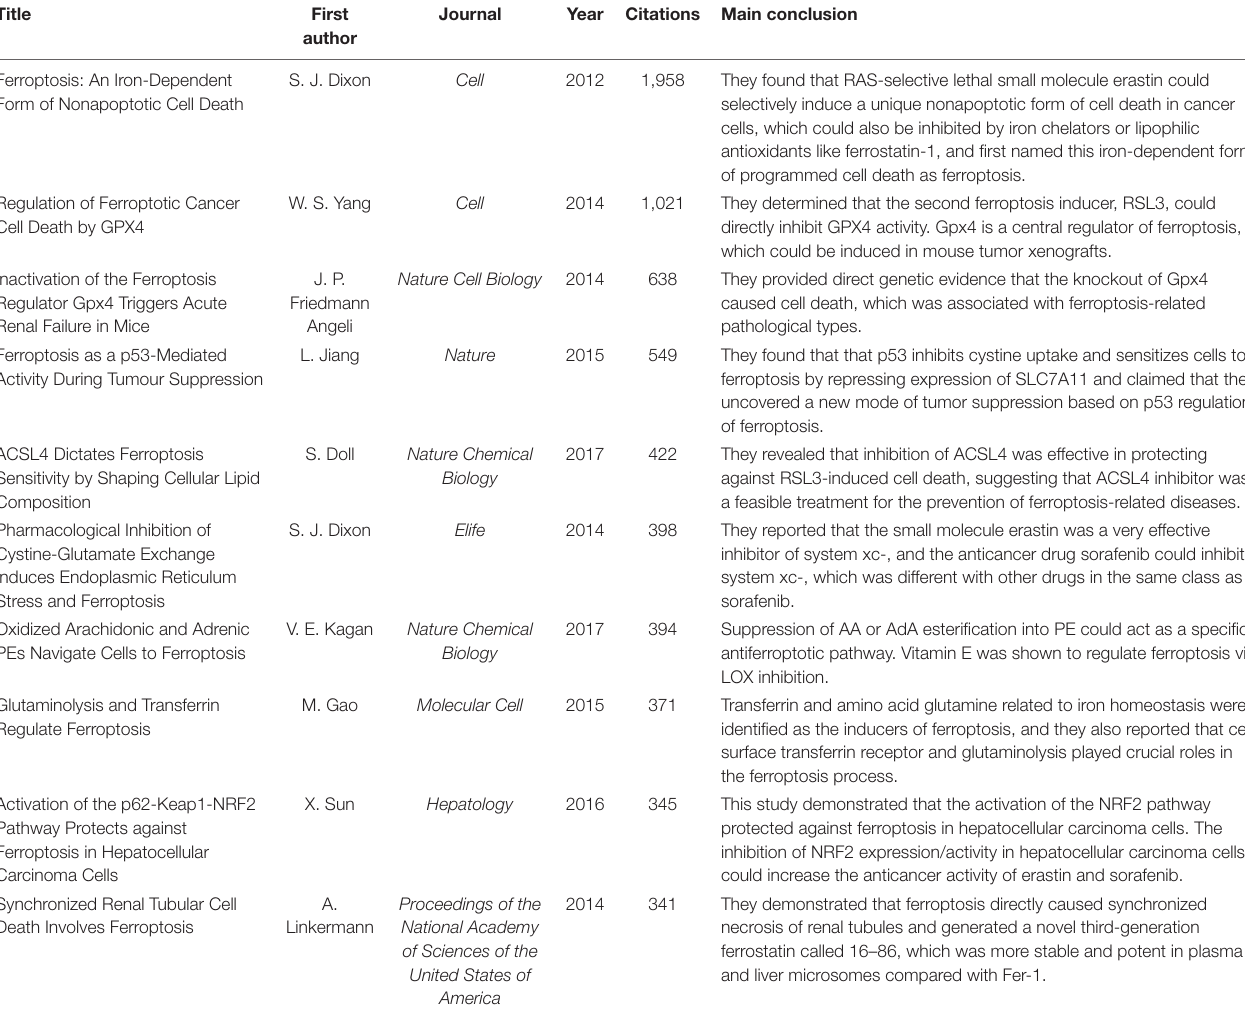
TABLE 5 | The top 10 ferroptosis-related original articles with the most citations (up to March 9,